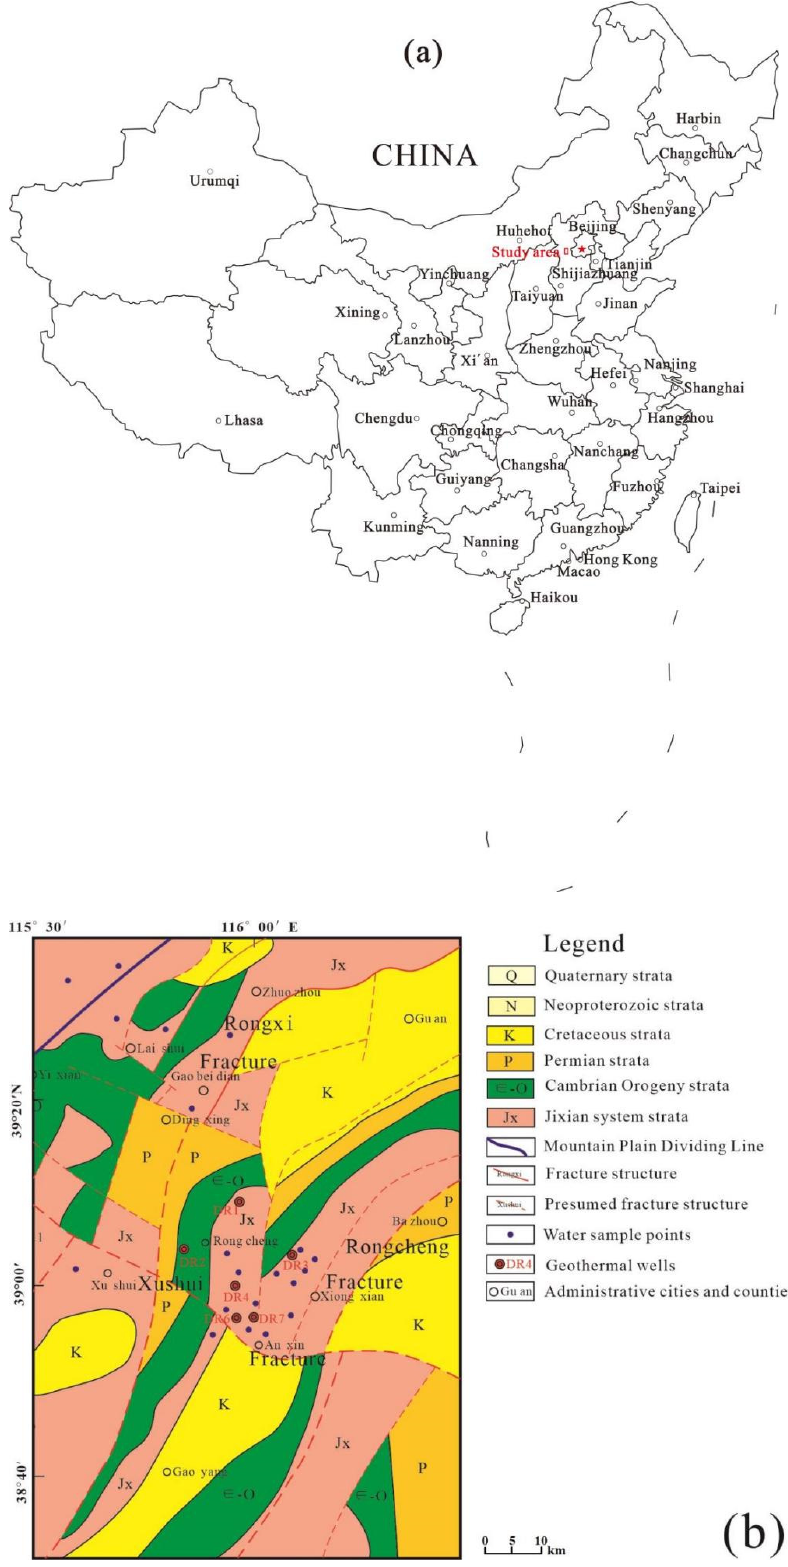
Figure 1. Map showing the study area in China ( a ) and geological map of Rongcheng Bulge area in Xiong’an New Area ( b ).